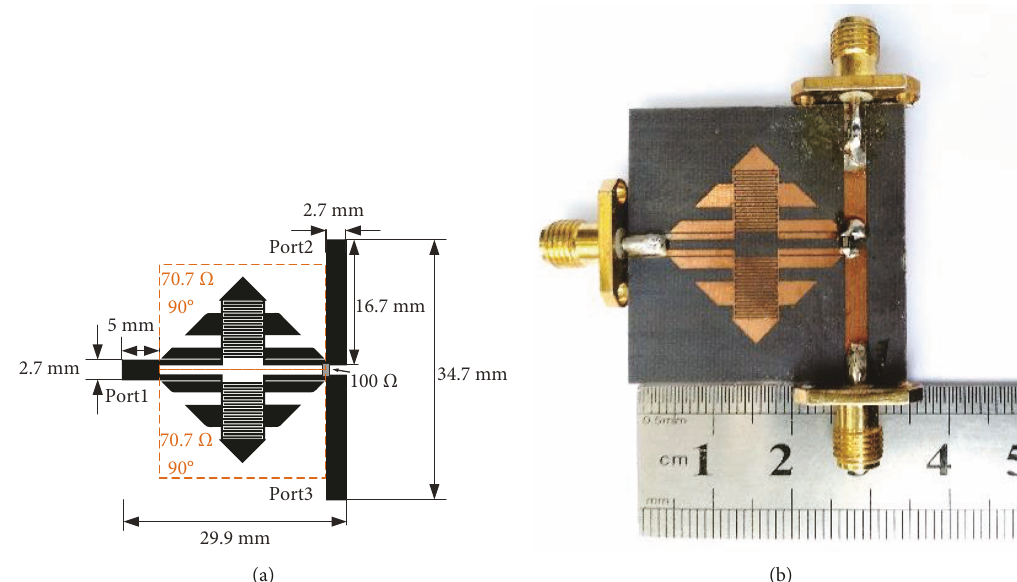
Figure 9: The proposed Wilkinson power divider: (a) layout and (b) photo.